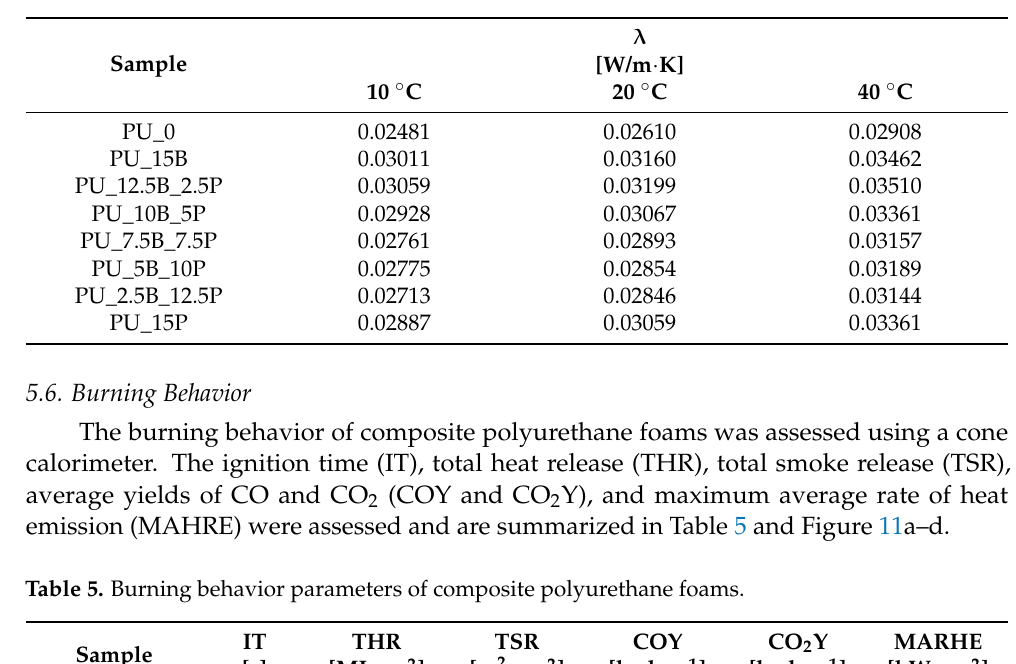
Table 4. Thermal conductivity coefficients at temperatures 10, 20, and 40 ◦ C.